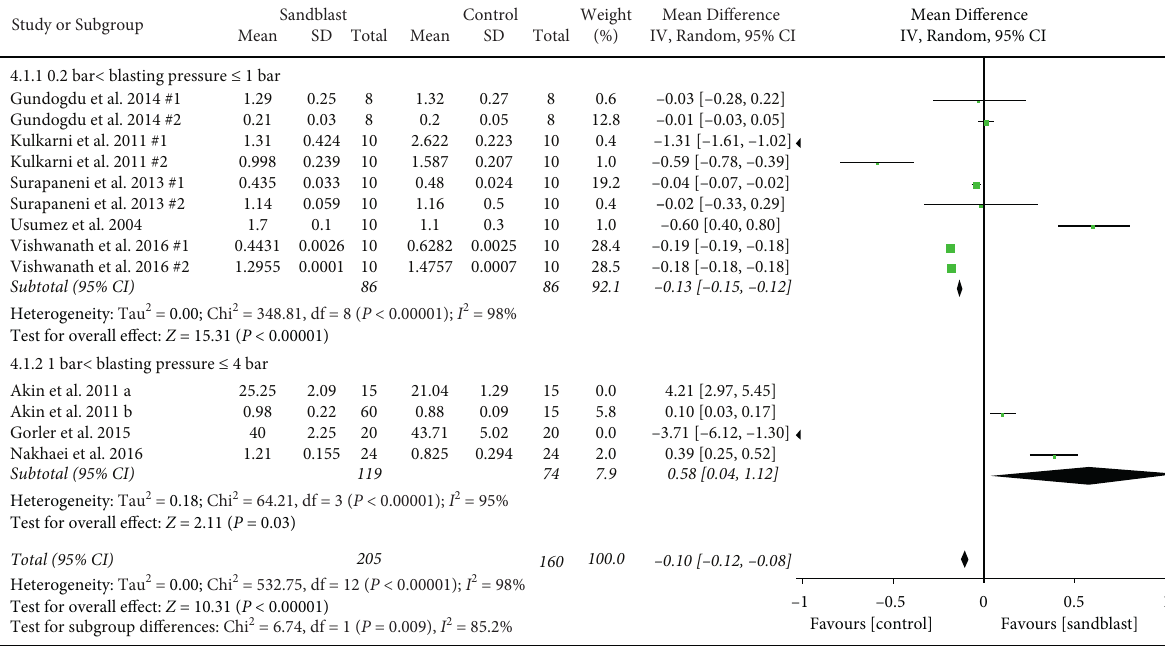
Figure 8: Forest plot for subgroup analysis of blasting pressure for tensile bond